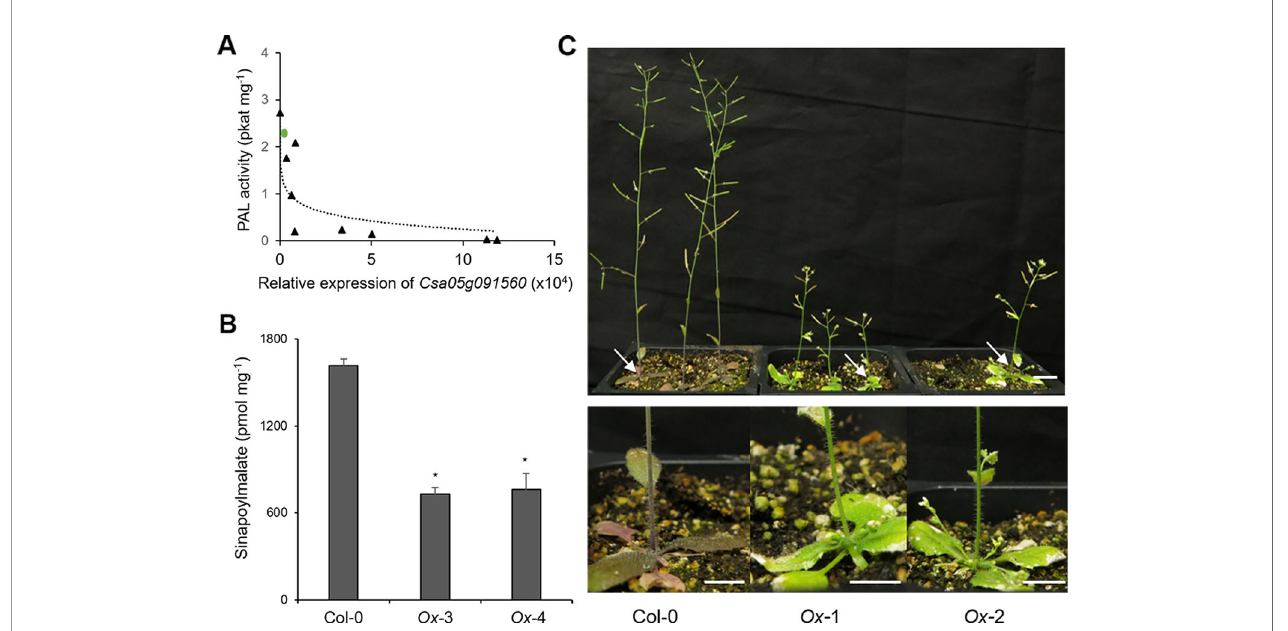
FIGURE 6 | Overexpression of Csa05g091560, one of the CsKFB50-like genes,reduces Phenylalanine ammonia lyase (PAL) activity and inhibits phenylpropanoid production in Arabidopsis. (A) PAL activity of nine Arabidopsis transgenic lines overexpressing Csa05g091560 is negatively correlated with the expression of Csa05g091560 . Green circle indicates PAL activity of Arabidopsis wild type. (B) Sinapoylmalate contents in Arabidopsis plants overexpressing Csa05g091560 . Soluble metabolites were extracted from 3-week-old plants grown on soil. Data represent mean ± SE of three independent experiments. * represents p < 0.05 (two- tailed student ’ s t-test) when compared with wild type. (C) Stunted growth and reduced anthocyanin accumulation of two transgenic lines overexpressing Csa05g091560 are shown compared with control plants (Col-0). Close-up images of plants show anthocyanin de fi ciency in the transgenic lines marked with arrows. (bars = 1 cm) Photos were taken fi ve weeks after